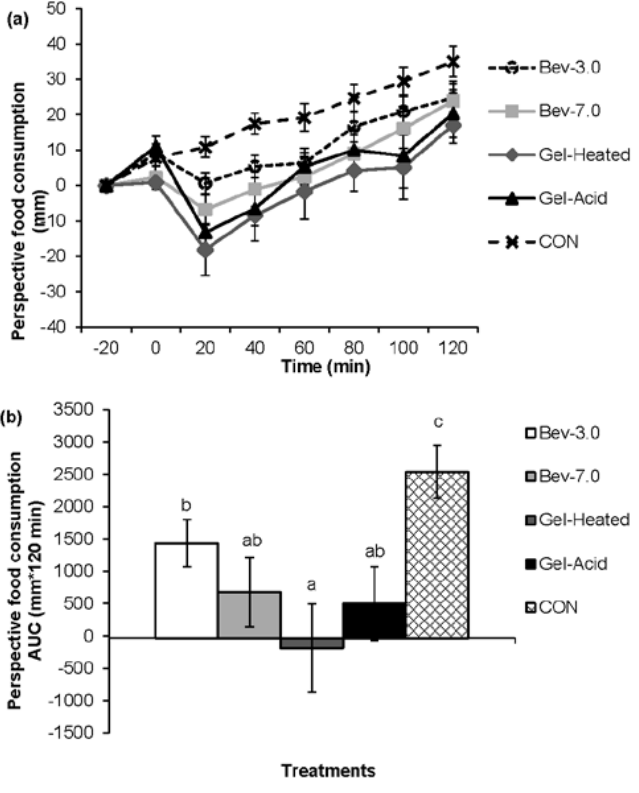
Figure 4. Perceived prospective food consumption across time for each treatment ( a , line graph) and